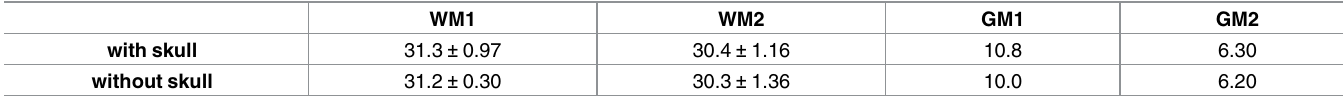
Table 2. SNR of each material for simulations with or without a skull. White matter (WM), Gray matter